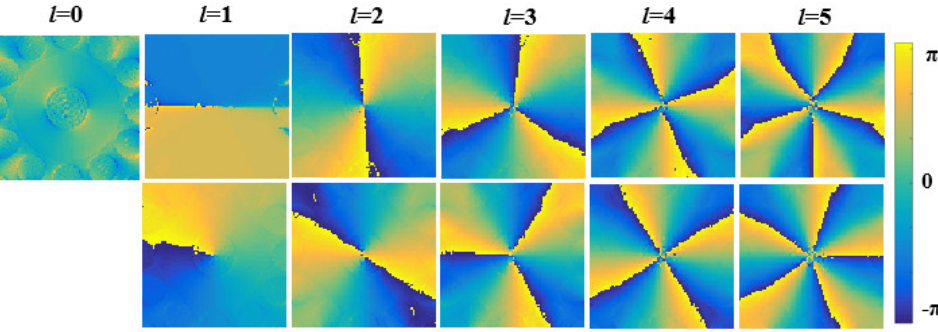
Figure 7. The polarization distribution of the OAM mode in the terahertz OAM PCF. The effective refractive index of the different vector modes is lies between 1.48 and 1.62, as shown in Figure 8a, which increases with the increase in the frequency. The EH and HE modes of the same mode group have similar effective refractive index. Then, the effective refractive index difference between adjacent modes supported by the designed PCF is given in Figure 8b. It can be seen that the effective refractive index for EH and HE modes decrease with the increase in the frequency. The effective refractive index differ- ence for EH and HE modes are above 10 −4 with the frequency range between 0.2 THz and 0.45 THz, which ensures that the OAM modes can be well separated and avoid de- generacy into LP modes. Due to the large effective index separation between the corre- sponding HE and EH modes for the same OAM mode group, the designed terahertz OAM PCF can realize stable transmission of OAM mode over long distances and broadband.